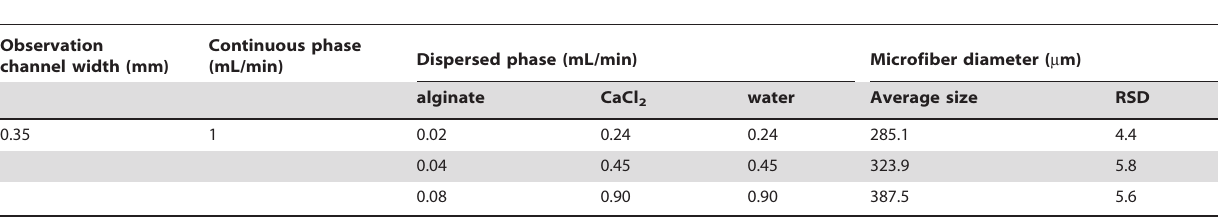
Observation channel width